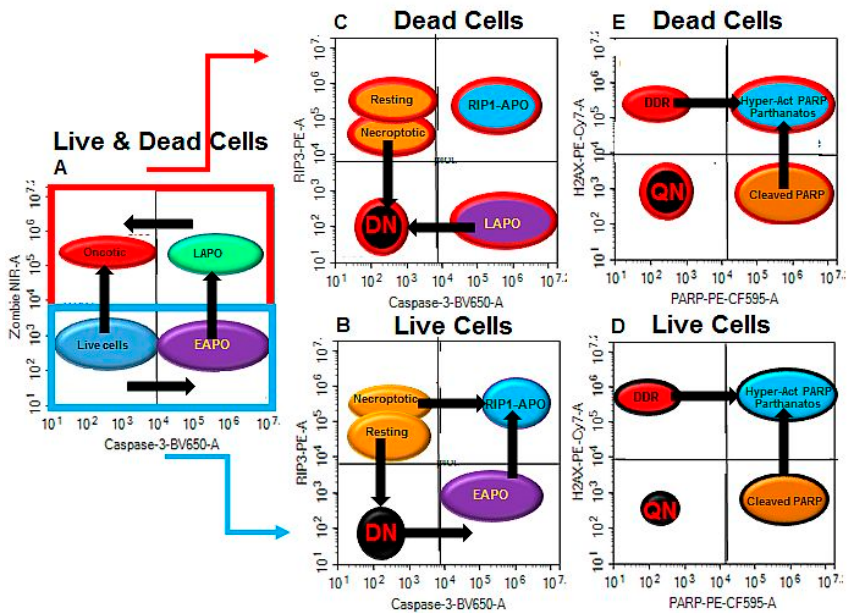
Figure 6. ACD and RCD pathways. ( A ) Live cells can undergo either early apoptosis (EAPO) or oncosis after drug treatment, with early apoptotic cells moving to late apoptotic (LAPO), then later with cell degradation, to the oncotic or necrotic phenotype. ( B ) Live cells may express RIP3 + ve / caspase-3 –ve when resting, or be RIP3 high + ve / caspase-3 –ve when undergoing necroptosis, or be double negative (DN). EAPO cells lose RIP3 or, if retained, undergo RIP1-dependent apoptosis (RIP1-APO). EAPO cells can also become RIP1 + ve . ( C ) Loss of plasma membrane integrity or cell death results in cell phenotypes mirrored in ( B ), with degradation of cells resulting in the DN population. ( B , C ) Live and dead cell phenotypes can also express pH2AX (DDR) or cleaved PARP (apoptosis), both of which can ultimately express both proteins, ( D , E ) resulting in pH2AX hyper-activation of cleaved PARP in the presence of active caspase-3 or parthanatos in the absence of caspase-3. Arrows indicate movement of cell